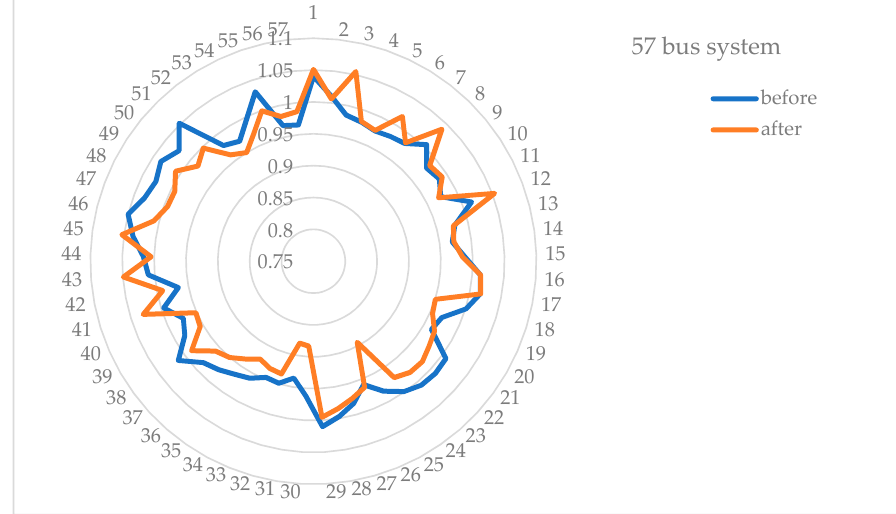
Figure 10. Bus voltages of 57 bus system before and after optimal reactive power dispatch (ORPD).